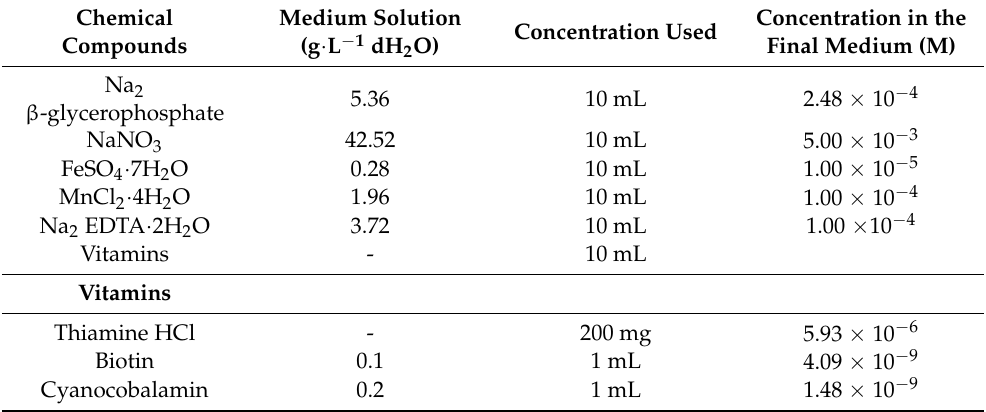
Table 1. Composition of von Stosch enrichment medium modified and adapted by Guiry and Cunningham